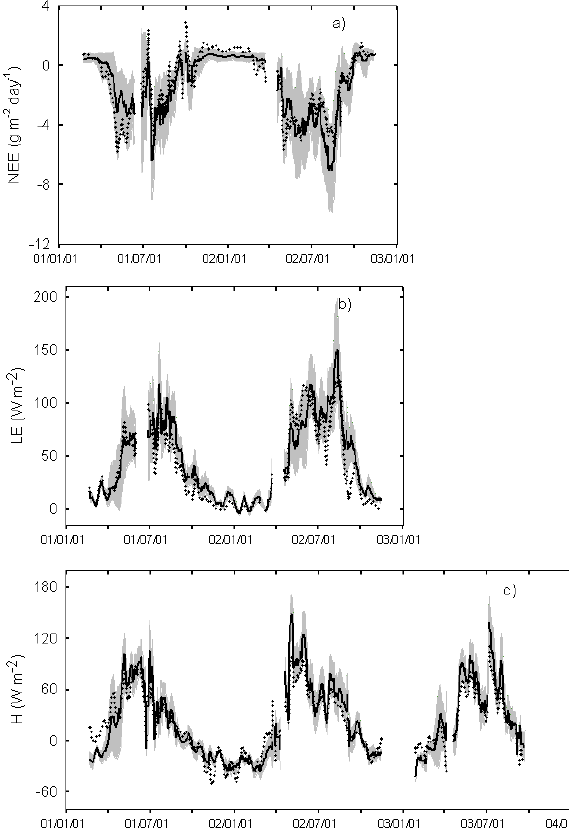
Fig. 7. Model performance on (a) NEE, (b) LE and (c) H based on DryTs when constrained by criteria C2 against corresponding measurements. The dotted line shows measured data. The solid line and grey area are the mean values and the 5-95% uncertainty band of simulated data based on 204 behavioural models. All values are 5-day averages.